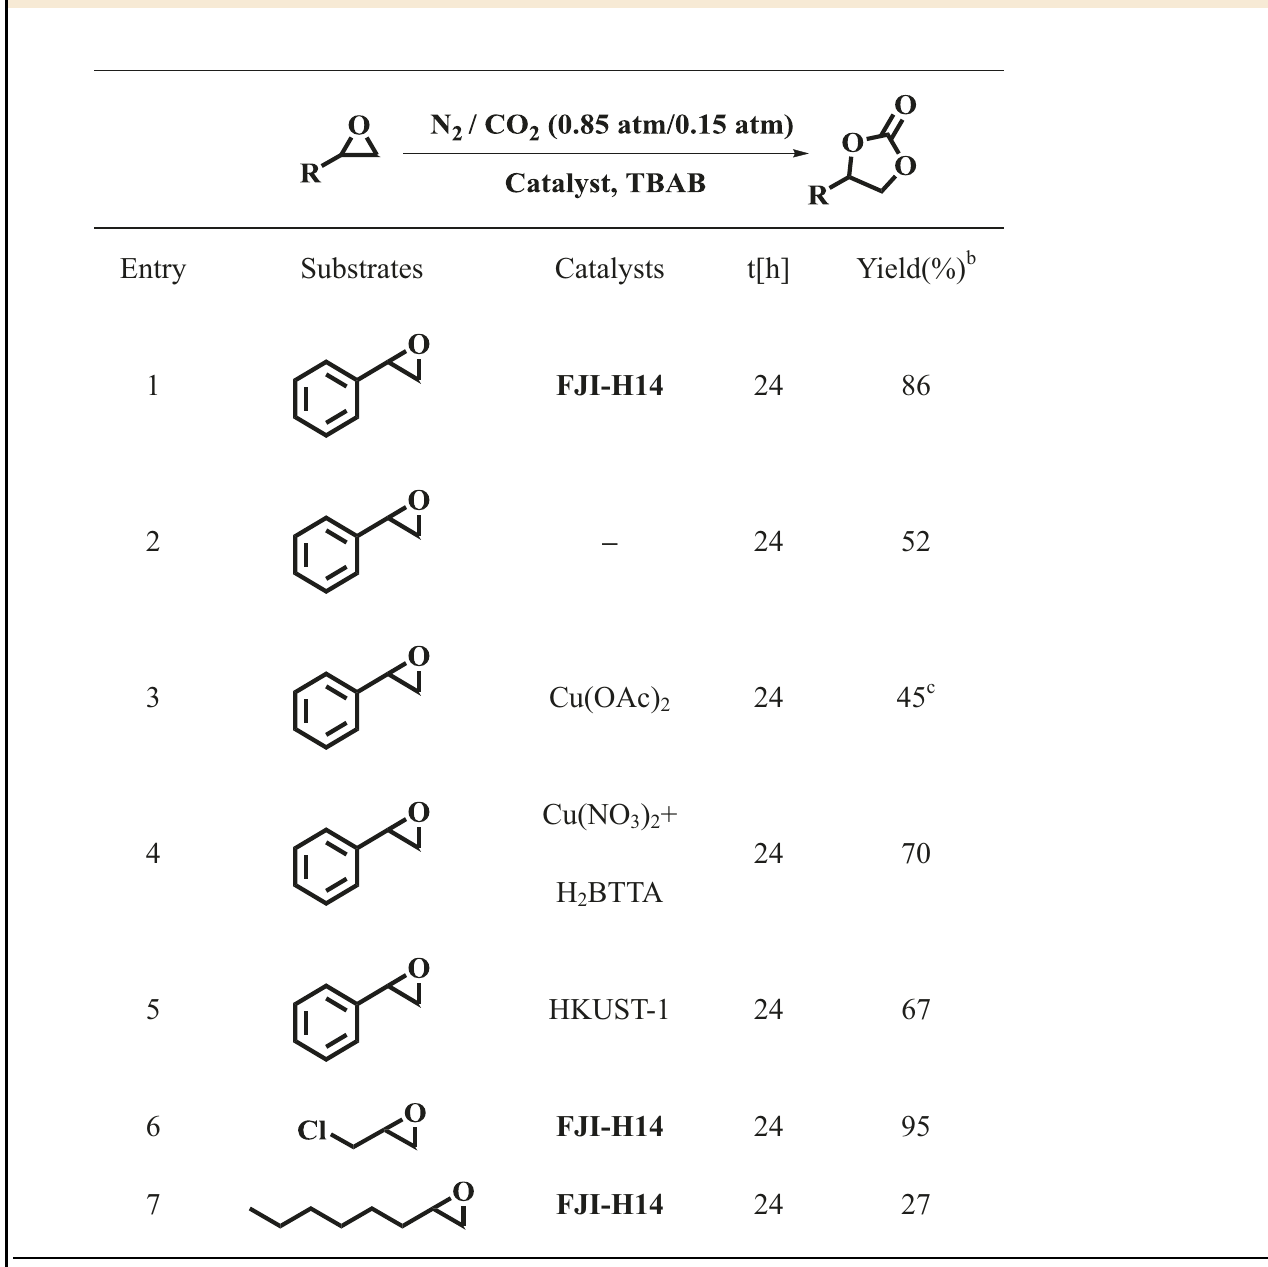
Table 1 Cyclic carbonates from epoxides and CO 2